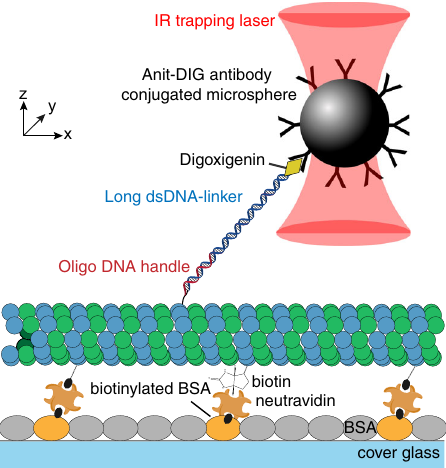
Fig. 2 Experimental setup of the tubulin pulling assay using an optical trap. Tubulin labeled with an oligo-DNA handle using the SSL method was linked to a long DNA linker through hybridization. Tubulin conjugated to the DNA-linker was polymerized with biotinylated tubulin and af fi xed to the surface of neutravidin-coated coverslips. The anti-digoxigenin antibody- coated microspheres were then bound to the DNA-linker labeled with digoxigenin. The mechanical force was exerted onto the α -tubulin CTT by pulling the microsphere with the optical trap along the y -axis, which is perpendicular to the long axis of microtubule ( x -axis).